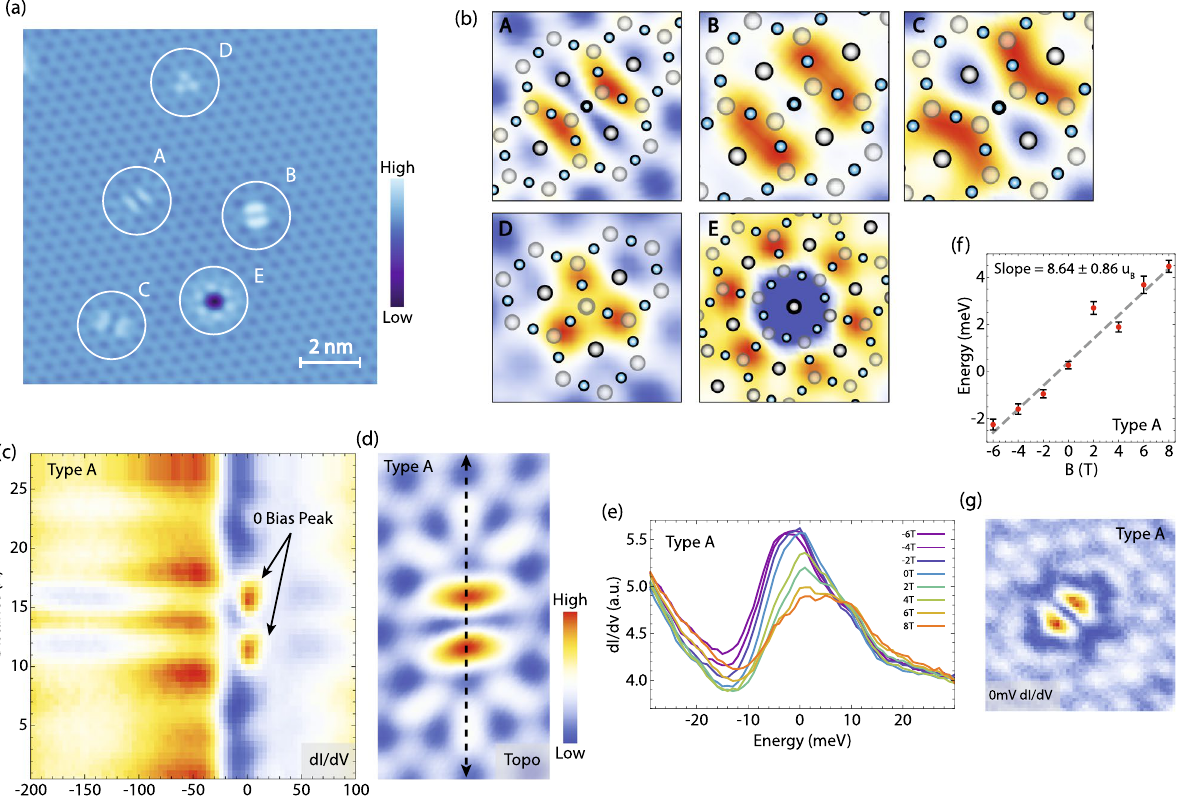
Figure 5. Impurities and field-tunable bound states. ( a ) STM topograph of the Sn surface containing several types of impurities labeled by different letters. ( b ) Zoom-ins on individual impurities circled in ( a ) with the lattice structure superimposed. ( c ) A linecut taken across a type A impurity center along its long axis of symmetry shown in ( d ). ( d ) A topograph of type A impurity. ( e ) dI/dV spectra taken over the bright resonances on either side of the center of the impurity A under magnetic fields from − 6 to 8 T applied perpendicular to the sample (minus sign denotes the reversal of magnetic field direction). ( f ) Fitted peak positions in ( e ) plotted as a function of magnetic field. The slope extracted from this linear dispersion is 8.64 ± 0:86 μ B . ( g ) dI/dV map at 0 mV of impurity A in ( a ). STM setup conditions: ( a , b ) I set = 100 pA, V sample = 20 mV; ( c – g ) I set = 600 pA, V sample = 100 mV, V exc = 3